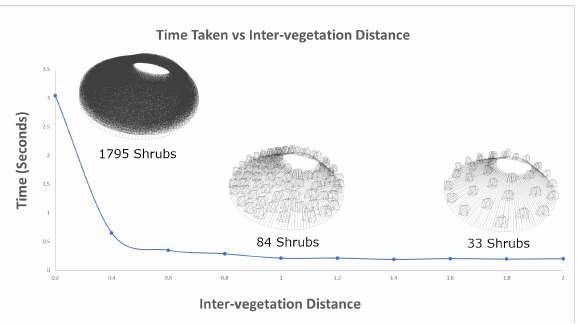
Figure 20. Placement performance with respect to planting